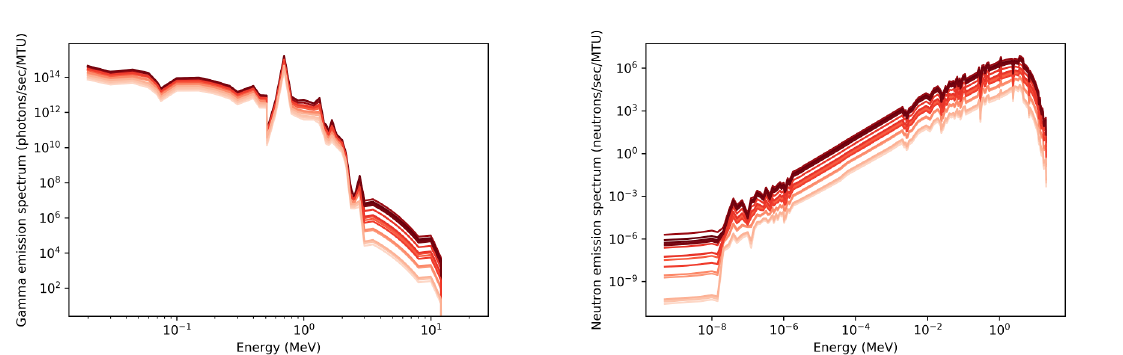
Figure 3: Calculated emission spectra of the twenty assemblies. Left: Gamma emission spectra (the darker red means higher gamma activity). Right: Neutron emission spectra (the coloring is the same as in Left side, thus darker red means higher gamma activity; MTU: metric ton of